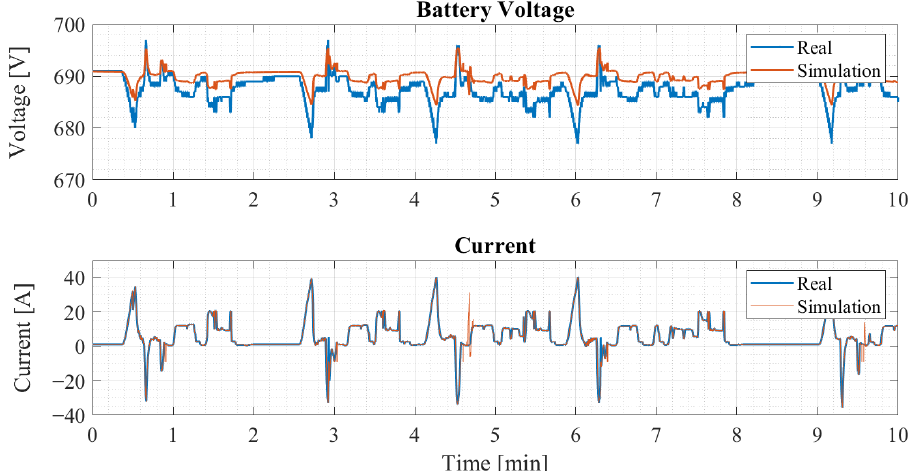
Figure 17. Representation of current and voltage amplitude during simulation and experimental test.